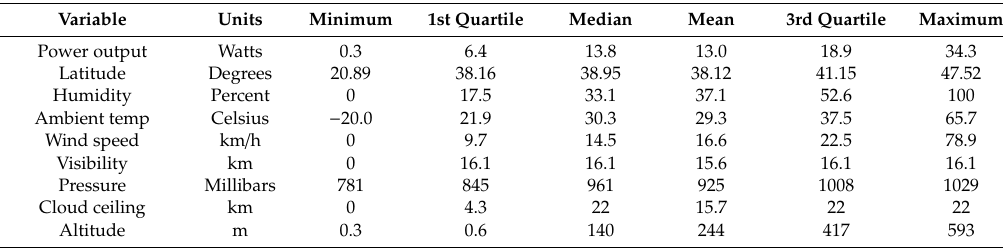
Table 3. Descriptive statistics for numeric variables.